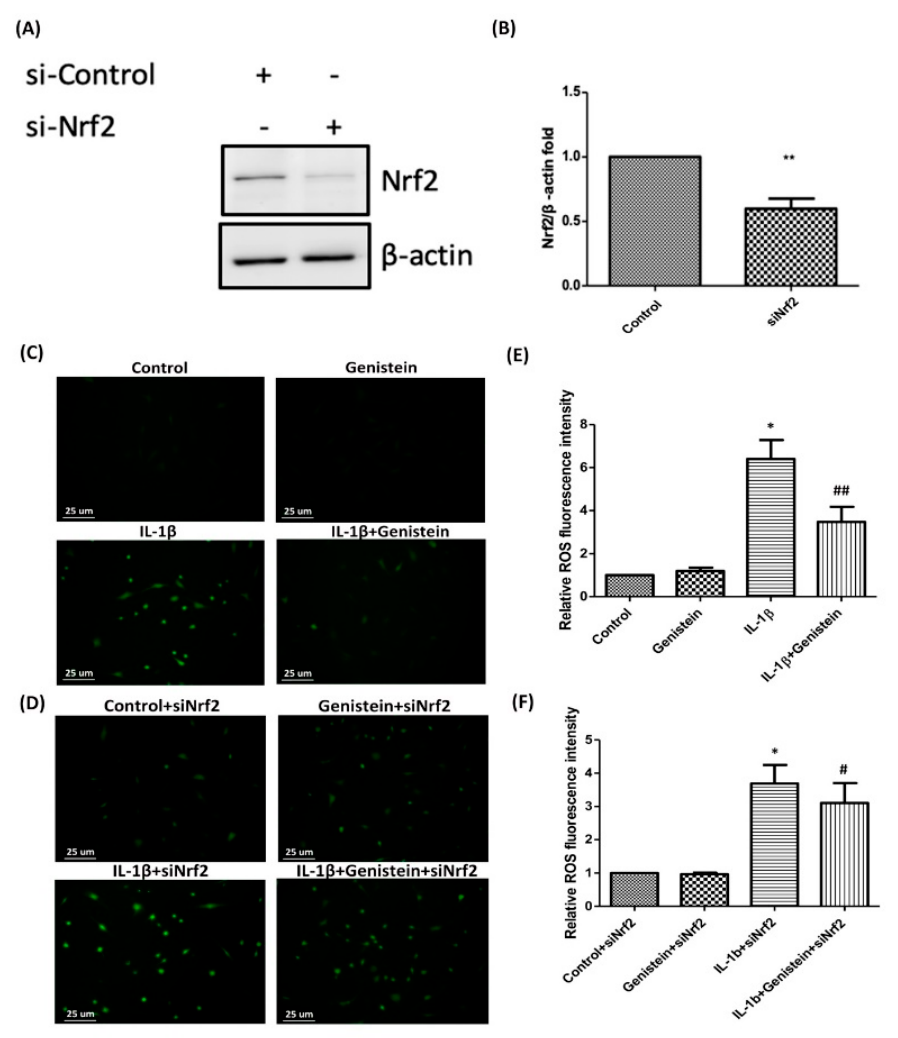
Figure 4. Nrf2 siRNA inhibits HO-1 expression and induces ROS generation in IL-1 β -induced human OA chondrocytes. Chondrocytes were transfected with Nrf2-siRNA, IL-1 β + Nrf2-siRNA, genistein + Nrf2-siRNA, or IL-1 β + genistein + Nrf2-siRNA for 24 h. ( A–B ) Levels of Nrf2 knock-down were detected using Western blot analysis. ( C–D ) Following treatment with genistein for 24 h, control and Nrf2 knock-down cells were stimulated using IL-1 β for 24 h. ROS fluorescence intensity was assessed using a fluorescence microscope. ( E–F ) Quantitative analysis of ROS fluorescence intensity was performed using Image J software. Results are presented as mean ± SD from at least three independent experiments. Significance was determined using a t -test. Significant di ff erences between the genistein group and the control group are indicated by an asterix (*); significant di ff erences between the genistein group and the IL-1 β group are indicated by a pound symbol (#). *, # p < 0.05; **, ## p < 0.01. Scale bars = 25 um.